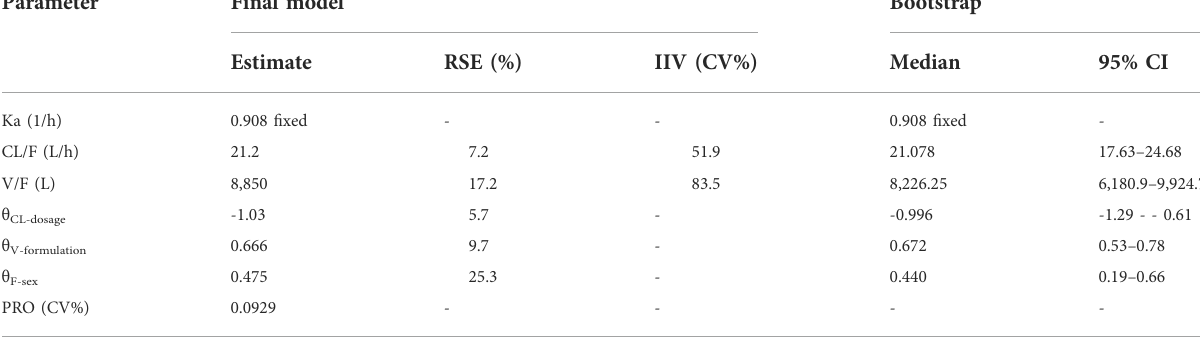
TABLE 2 Population pharmacokinetic parameters estimates and bootstrap results of